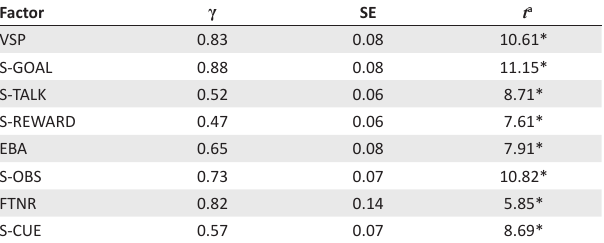
TABLE 7: Latent variable intercorrelations between second-order self-leadership and first-order factors (unstandardised gamma matrix). Factor γ SE t